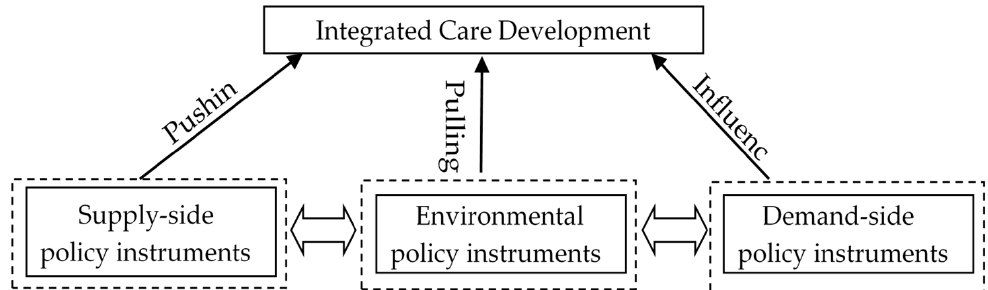
Figure 1. The Policy Instruments for Integrated Care.